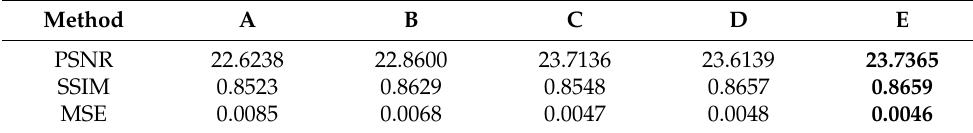
Figure 13. Comparative image of the ablation experiment. Module E compares the model used in this paper, in three rows of images, with superior results. Table 3. Comparison of test indicators for ablation experiments.